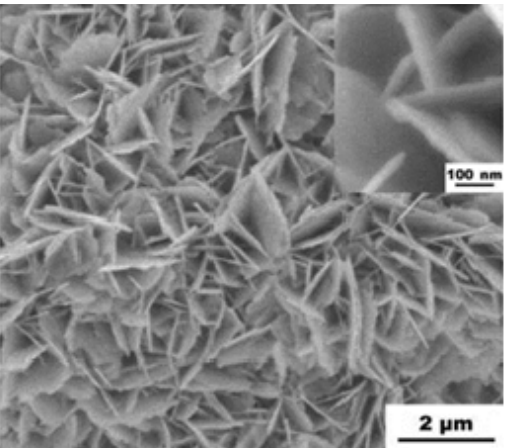
Fig. 7: SEM image of 2D staggered silver nanosheets deposited Fig. 6: Schematic illustration of the electroless plating method. on an aluminum foil. Reproduced with permission from ref.37, Reproduced with permission from ref.35, copyright 2013, copyright 2005, IOP Springer.